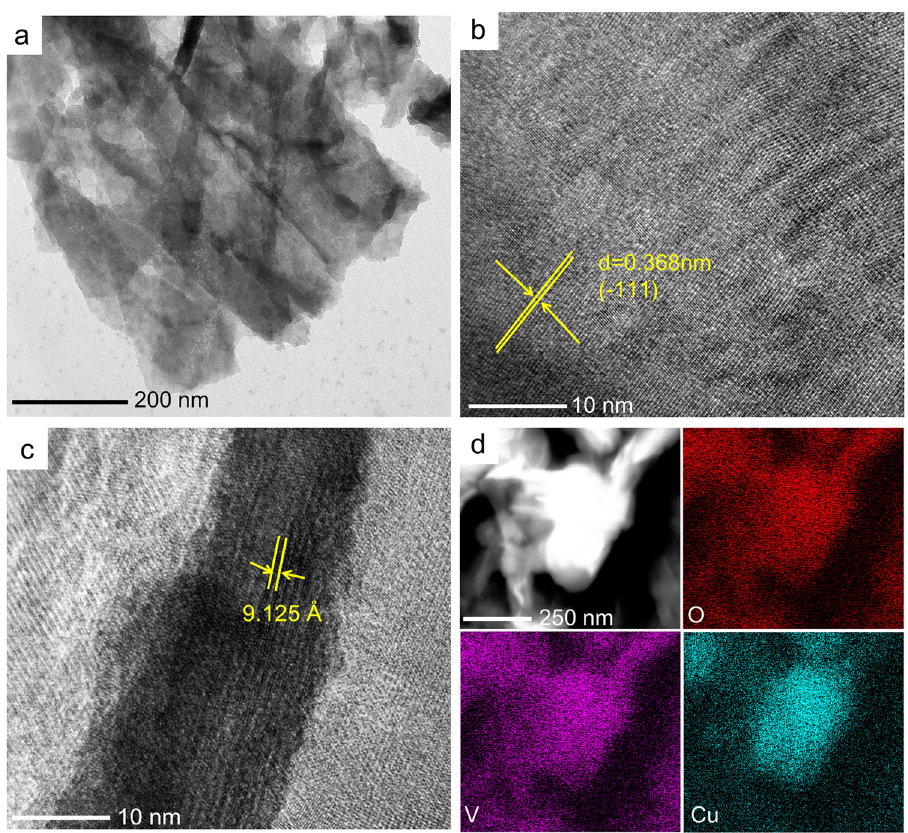
Figure 3: ( a ) TEM image of CVO - 2, showing good uniformity in terms of size and morphology. ( b ) and ( c ) High - resolution TEM image. ( d ) SEM image and elemental mappings of V, O, and Cu of CVO -